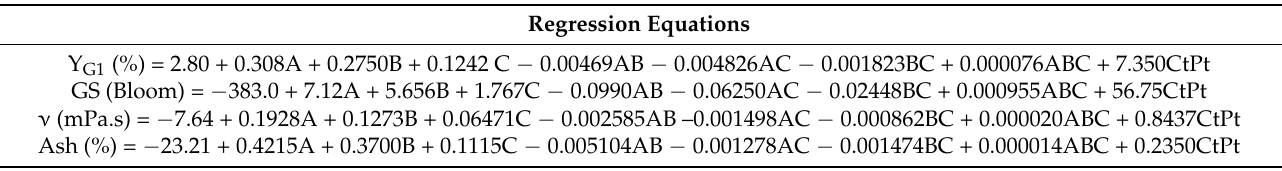
Table 3. Regression equations for first gelatin fraction yield, gelatin gel strength, gelatin viscosity and gelatin ash content. Regression Equations